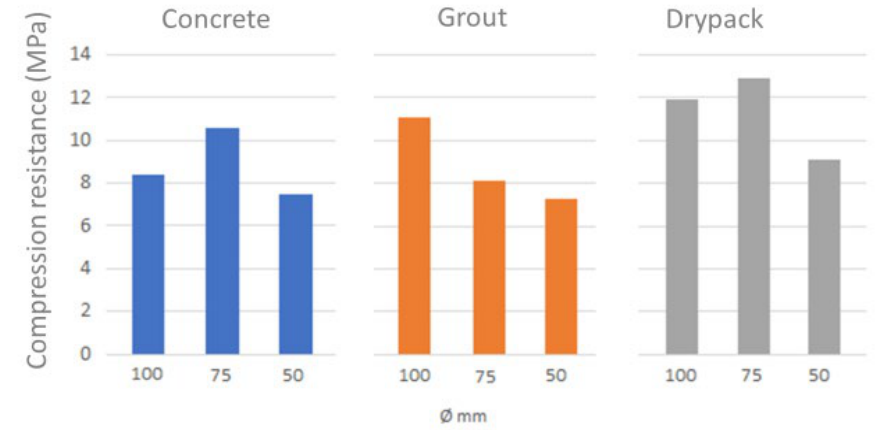
Figure 7 – Relative effect of diameter in repair material